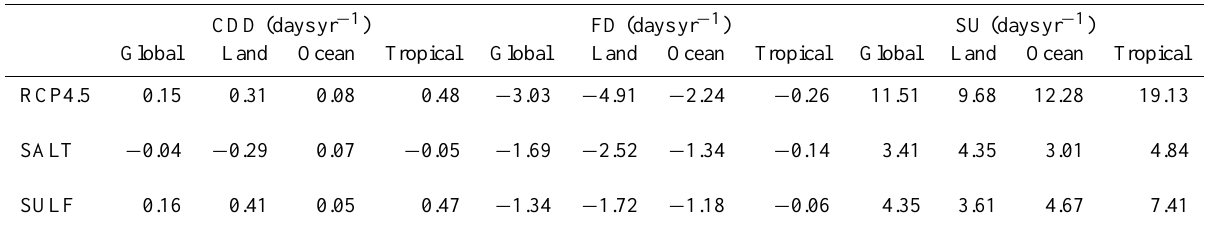
Table 4. Change in CDD, FD and SU for the 2040–2069 period with respect to the CTL period. CDD (daysyr − 1 ) FD (daysyr − 1 ) SU (daysyr − 1 ) Global Land Ocean Tropical Global Land Ocean Tropical Global Land Ocean Tropical RCP4.5 0.15 0.31 0.08 0.48 SALT SULF 0.16 0.41 0.05